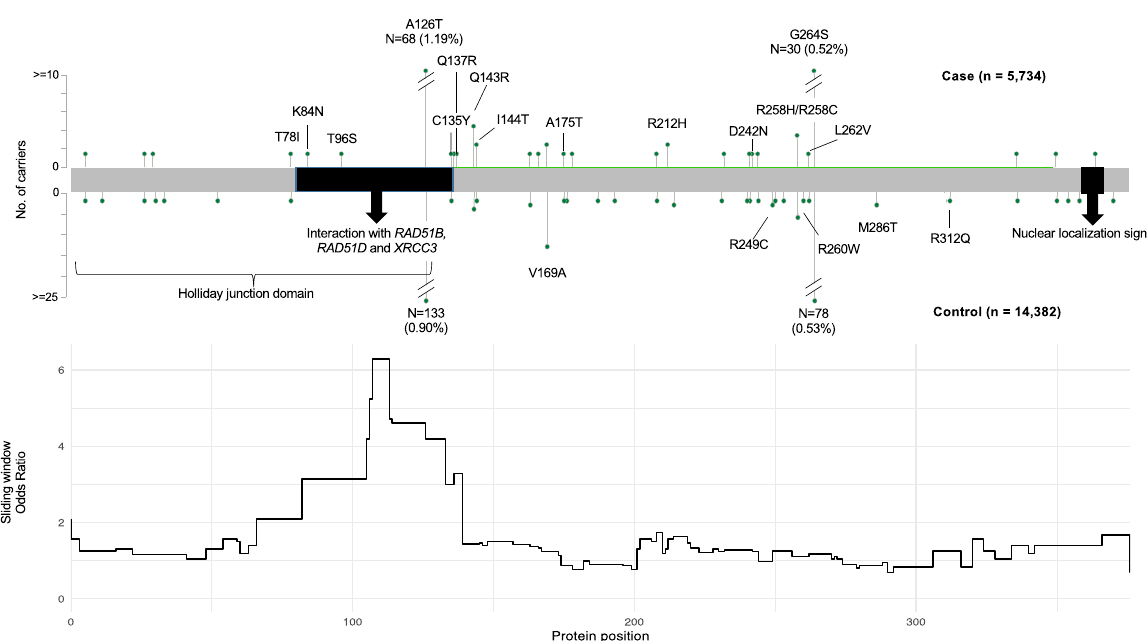
Fig. 1 The location and frequency of RAD51C MS variants detected in cases ( n = 5734) and controls ( n = 14,382), and case – control odds ratios in position-based analysis. Key variants are marked with protein change and variants of interest are pointed with arrows. Holliday junction domain includes protein position 1 – 126, domain interacting with RAD51B, RAD51D and XRCC3 include protein position 79 – 136. p.Ala126Thr, an accepted benign variant, is included as a reference in this fi gure but not in the analysis. Note the y -axis scale is different for cases and controls, accounting for the control cohort being more than twice as larger than the case cohort.